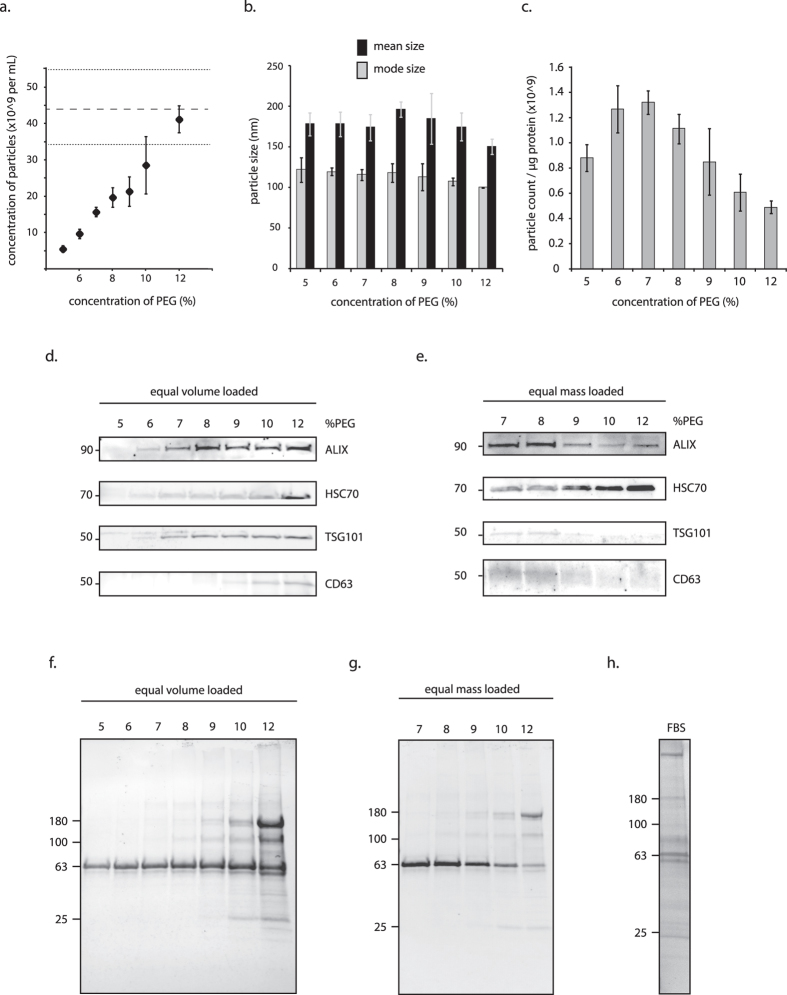
Polyethylene glycol enriches vesicles containing exosome proteins.(a) Nanoparticle tracking analysis identified particles in all PEG treatments. The greatest number of particles were recovered using 12% PEG (dashed line represents baseline particle count: particles harvested from conditioned medium assessed by NTA prior to PEG treatment; bounded by one standard deviation). (b) No differences in particle size between groups were detected. (c) Purity was plotted as a ratio of particles recovered to micrograms of protein in sample. Sample purity peaked when PEG concentrations of 6 to 8% were used. (d,e) Lysates were evaluated for exosome protein. Equal-volume (35uL) or equal-mass (8 μg) gel-loading was used to evaluate exosome recovery and purity, respectively. (f,g) Blots were Ponceau stained to evaluate total protein, and compared to (h) fetal bovine serum protein (FBS) alone (protein recovered from PEG-treated, unconditioned culture medium, with 10% FBS). All approximate protein masses are represented in kilodaltons (kDa).